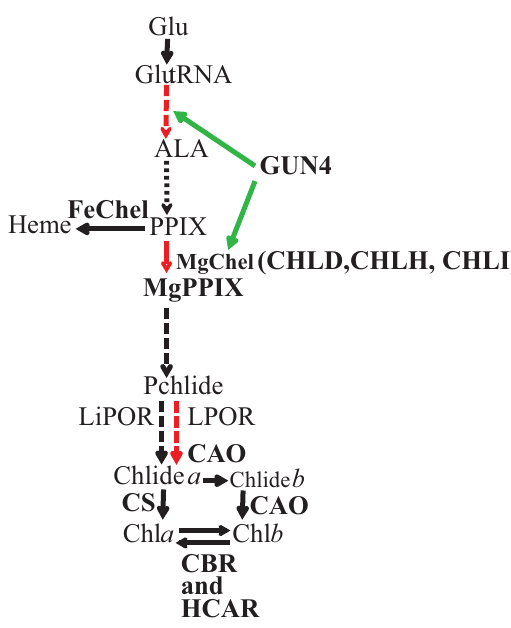
Figure 1. A simplified tetrapyrrole biosynthetic pathway. Light regulated steps are in red. Dashed arrows denote multiple enzymatic steps and green arrows point to steps that are positively regulated by the GUN4 protein, respectively. Tetrapyrrole intermediates and enzymes are shown in black and bold black type, respectively. Readers are advised to look in the text for full names of tetrapyrrole intermediates and enzymes, which are abbreviated in this